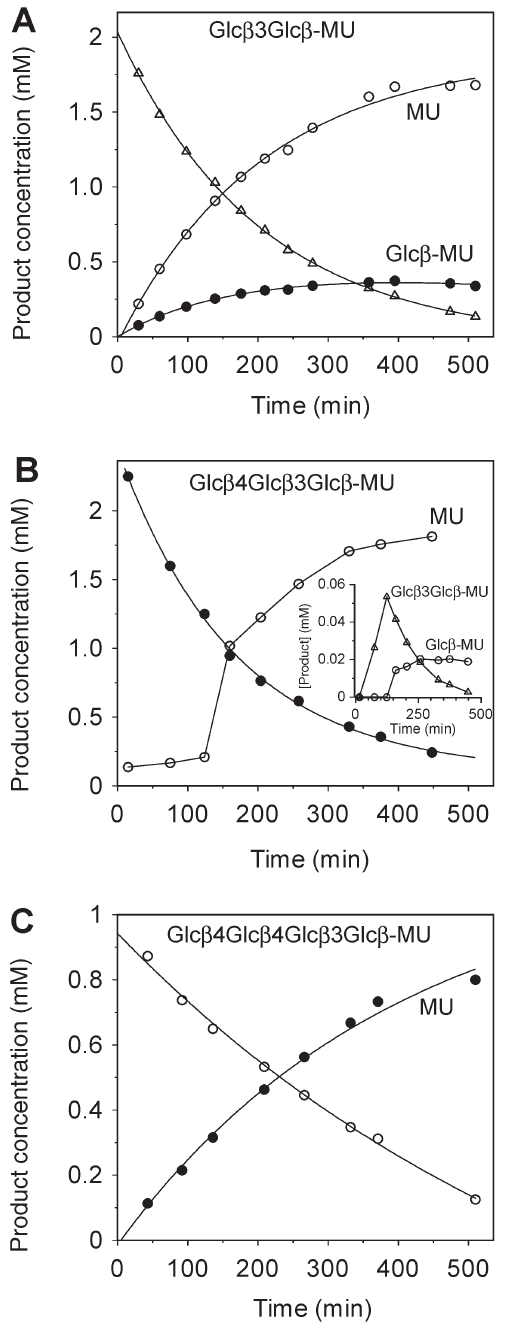
Figure 3. Time course of the hydrolysis of 4-methylumbelliferyl β -glycosidescatalyzedby 0.02 µM wild-typeLamA from Pyrococcus furiosus i n 100 mM phosphate buffer, pH 6.5, at 80 °C. (A) Substrate Glc β 3Glc β -MU (1); (B) substrate Glc β 4Glc β 3Glc β -MU (2); and (C) substrate Glc β 4Glc β 4Glc β 3Glc β -MU